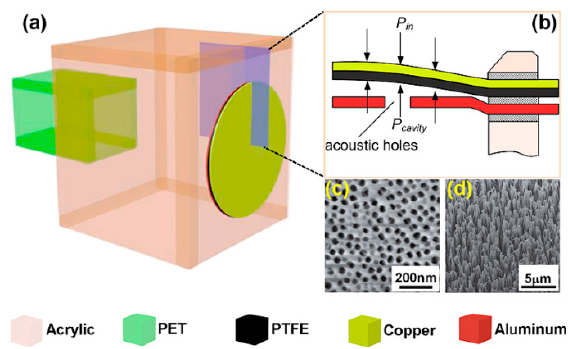
Figure 15. Schematic diagram of the nanogenerator-based AEH device. ( a ) AEH Structure; ( b ) cross-sectional view of the triboelectric nanogenerator (TENG); ( c ) SEM image of the pores on the electrode; ( d ) SEM image of the nanowires. Reproduced with permission from [49]; published by ACS NANO, 2014.